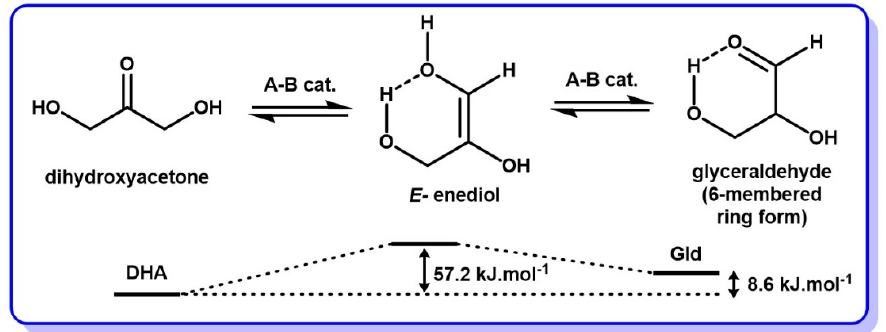
Figure 8. DHA–Gld interconversion mechanism through an enediol intermediate. Energy diagram obtained with B3LYP/6-31G* model, adapted with permission of the Royal Society of Chemistry from [7]; permission conveyed through Copyright Clearance Center, Inc.